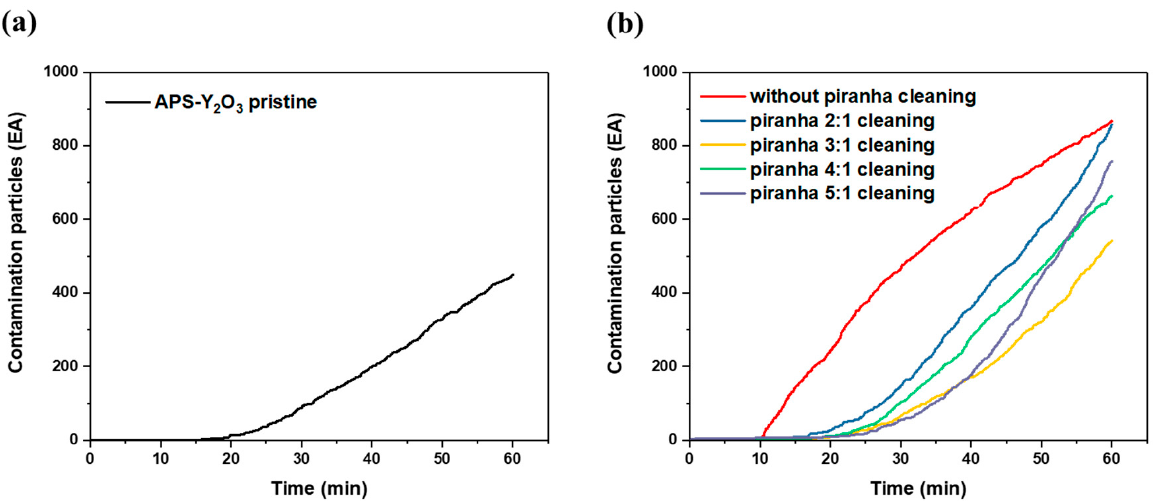
Figure 9. Real-time detection of contamination particles generated from the APS–Y 2 O 3 coating: ( a ) pristine APS–Y 2 O 3 , ( b ) with and without cleaning with the piranha solution.